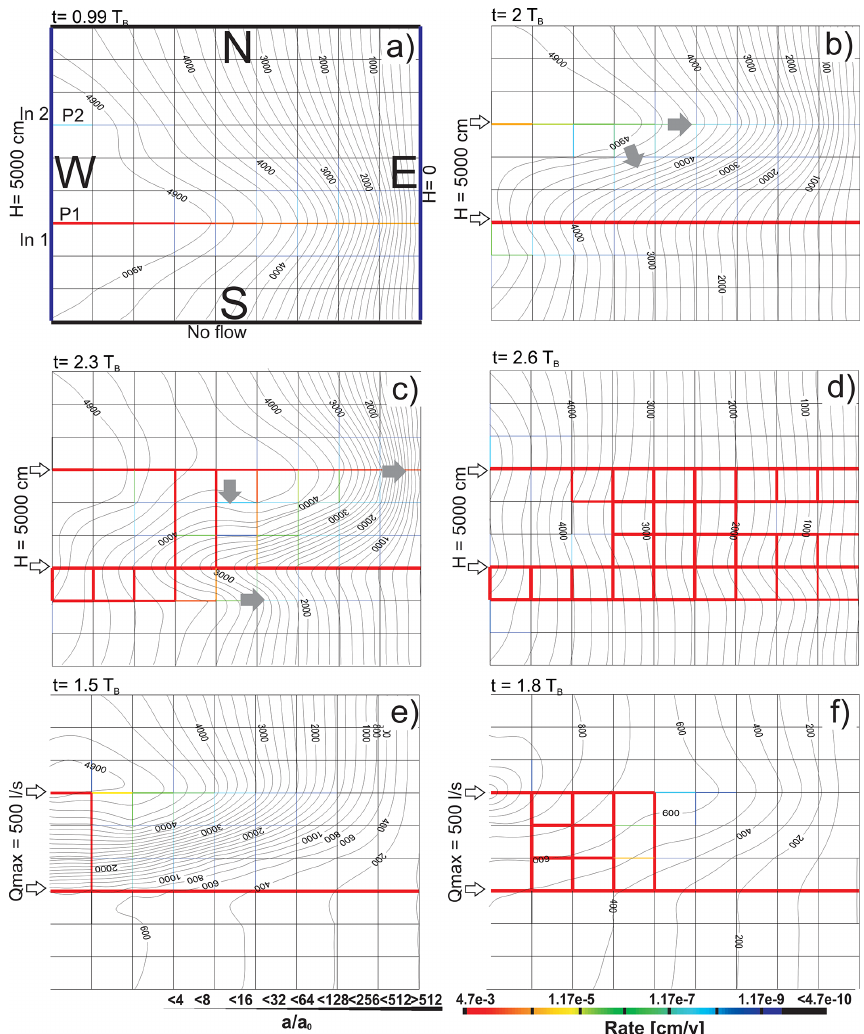
Figure 1. Evolution of 2-D fracture network under pressurized flow. Panels show aperture widths and dissolution rates at different stage of evolution. Size of the domain is 1km × 1km, initial aperture width a 0 = 0.02cm, except for the line P1 , where a 0 = 0.03cm. Linear and forth order dissolution kinetics for the limestone is used (see Dreybrodt et al., 2005 for